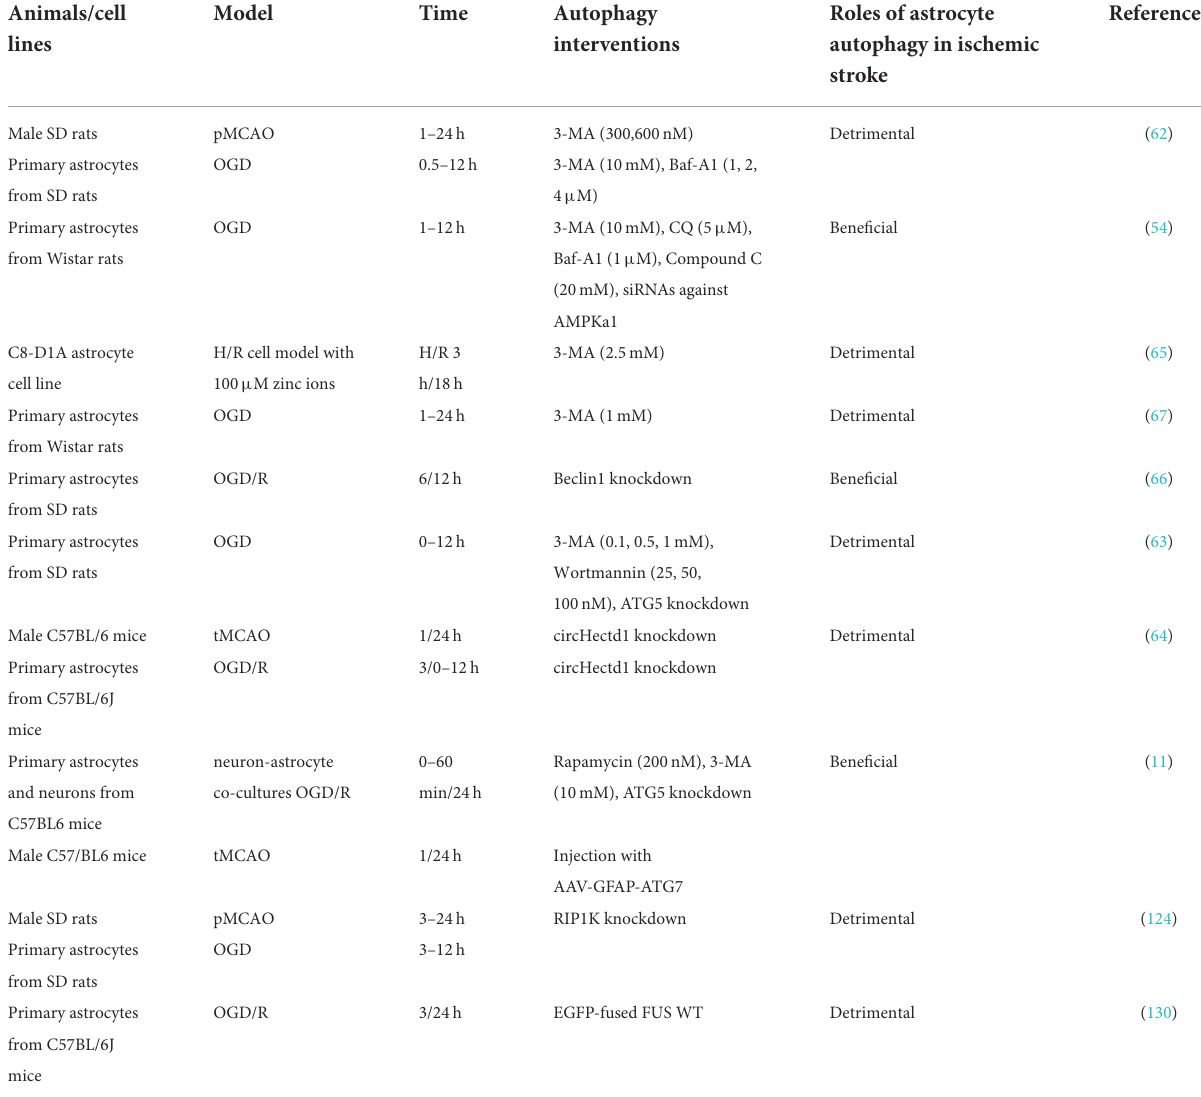
TABLE 1 Roles of astrocyte autophagy in experimental models of ischemic